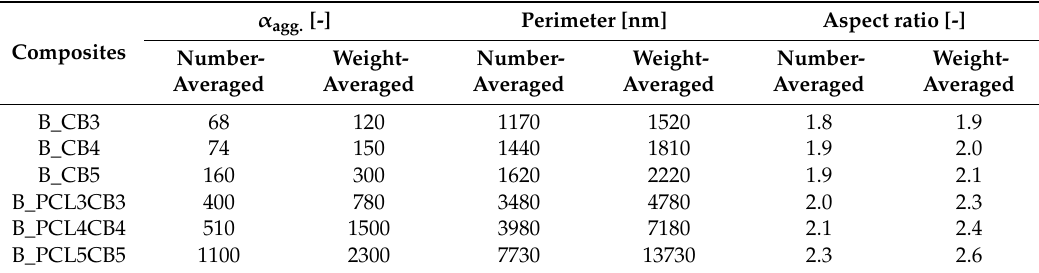
Table 3. Geometric characteristics ( α agg , Perimeter, Aspect ratio) of CB aggregates in B_composites depending on the content of the CB and PCL